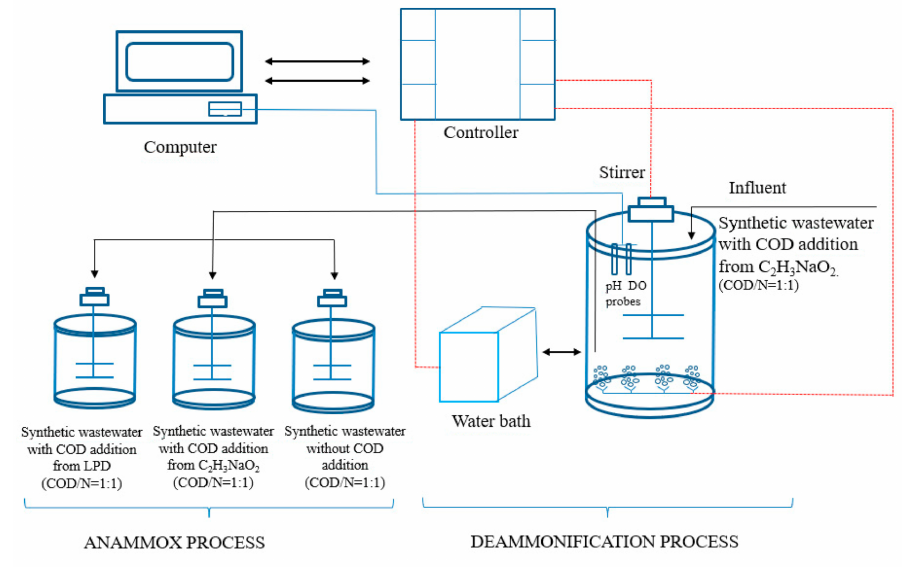
Figure 1. Scheme of the laboratory